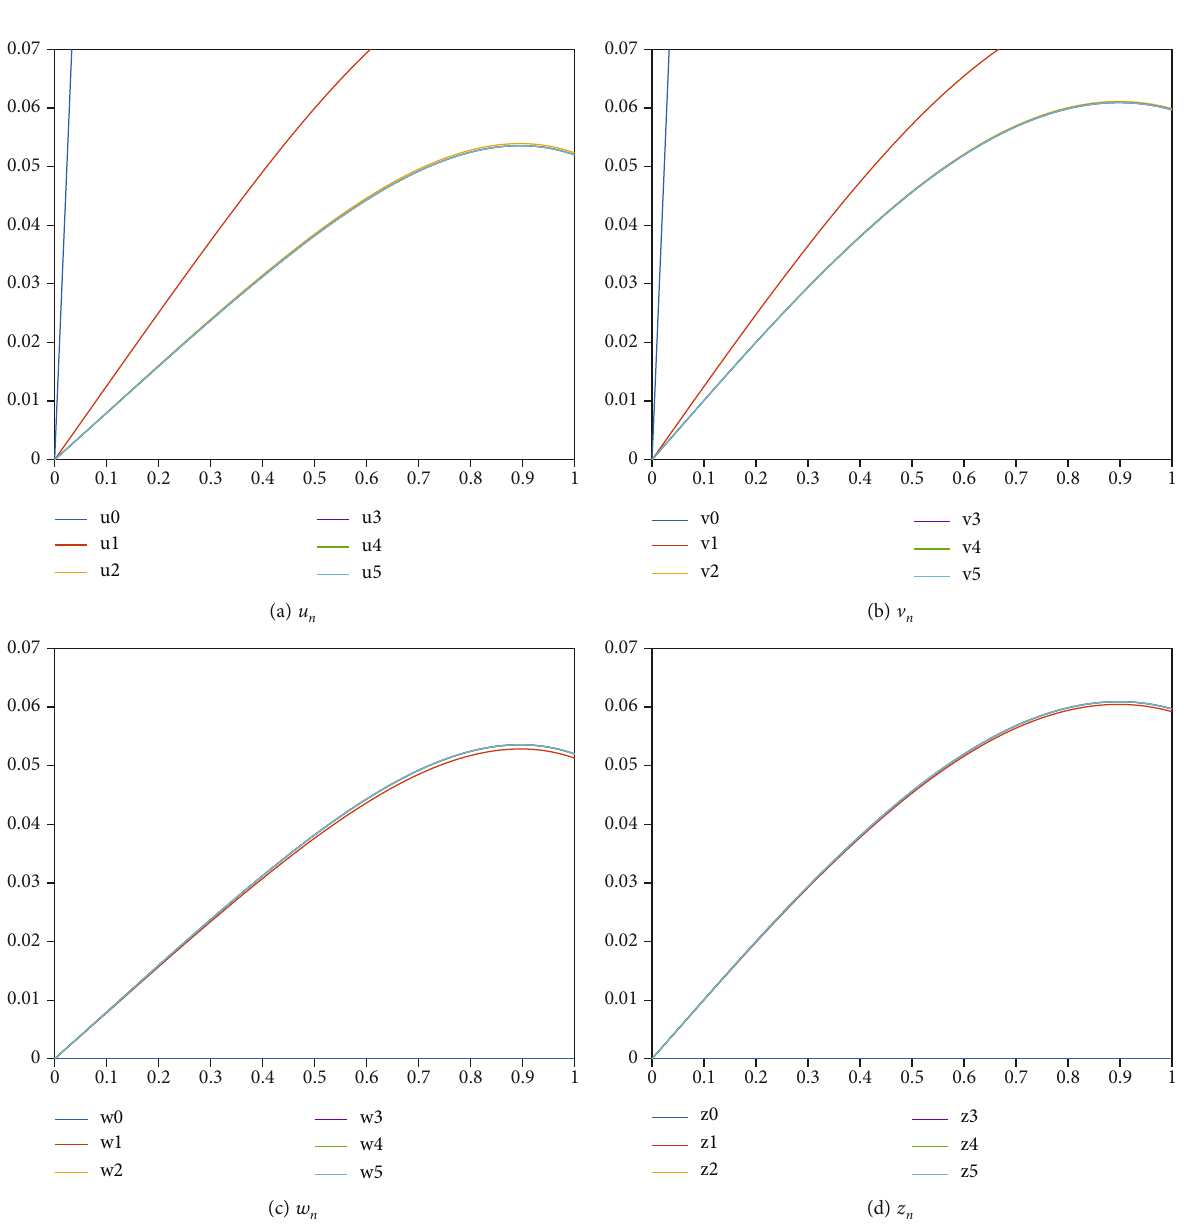
Figure 2: A plot of the solutions of Example